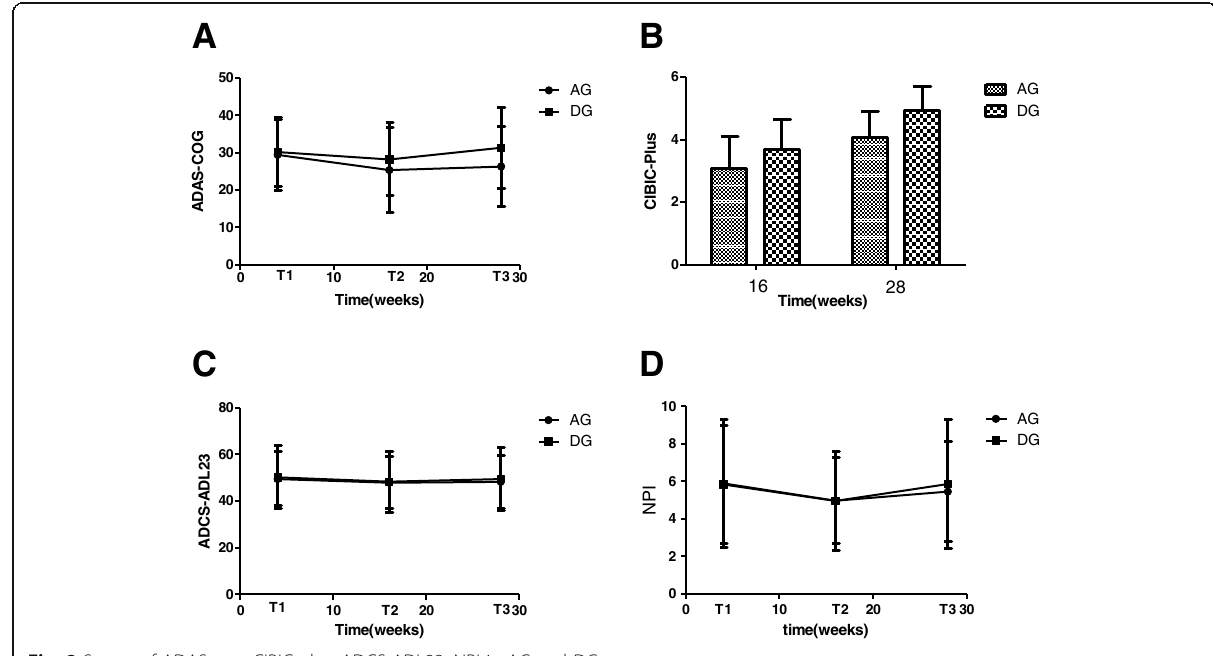
Fig. 2 Scores of ADAS-cog, CIBIC-plus, ADCS-ADL23, NPI in AG and